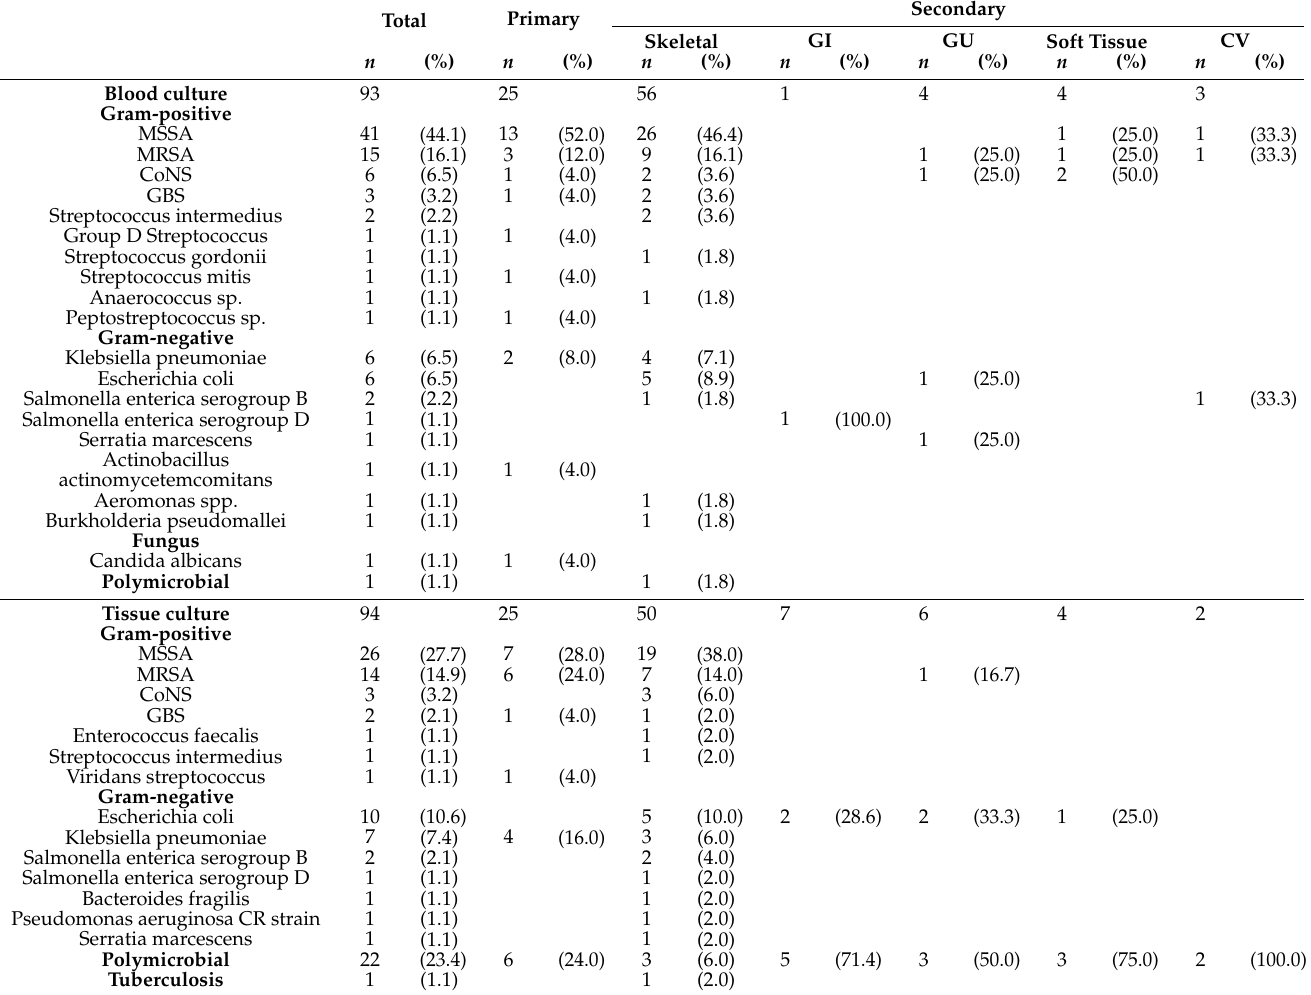
Table 3. Microbiology results of blood cultures and tissue cultures stratified by primary and secondary